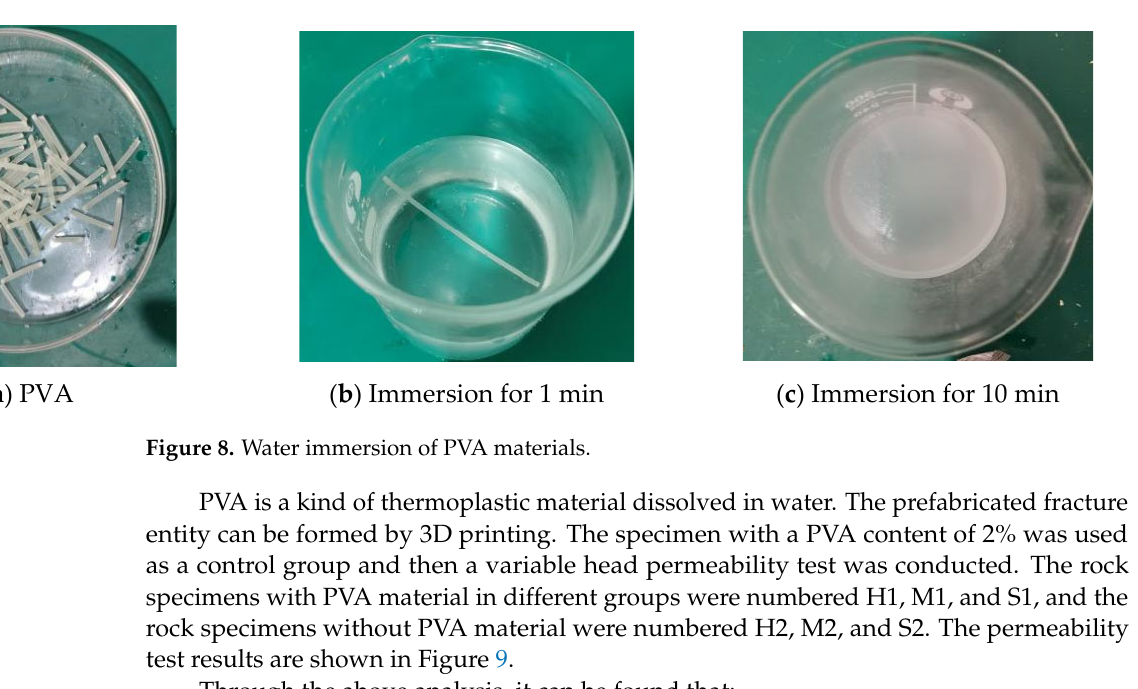
Figure 9. Permeability test of specimens. Through the above analysis, it can be found that: 1.